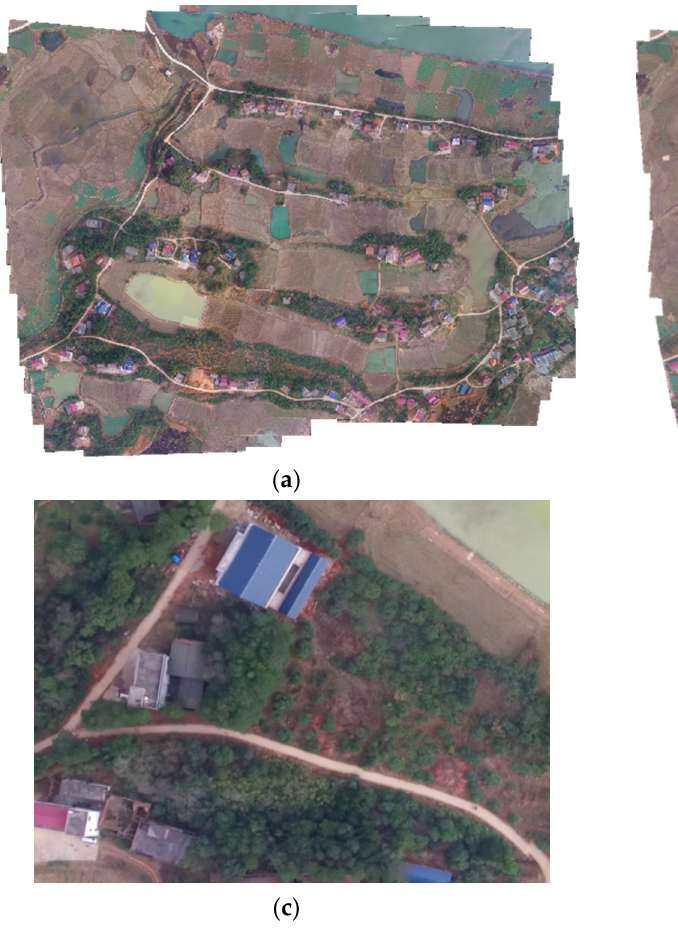
Figure 6. Comparison of sequences. Original Phantom3-village ( a ) and the randomly processed one ( b ). Images ( c , d ) are the detail of the yellow dash box in panorama s .